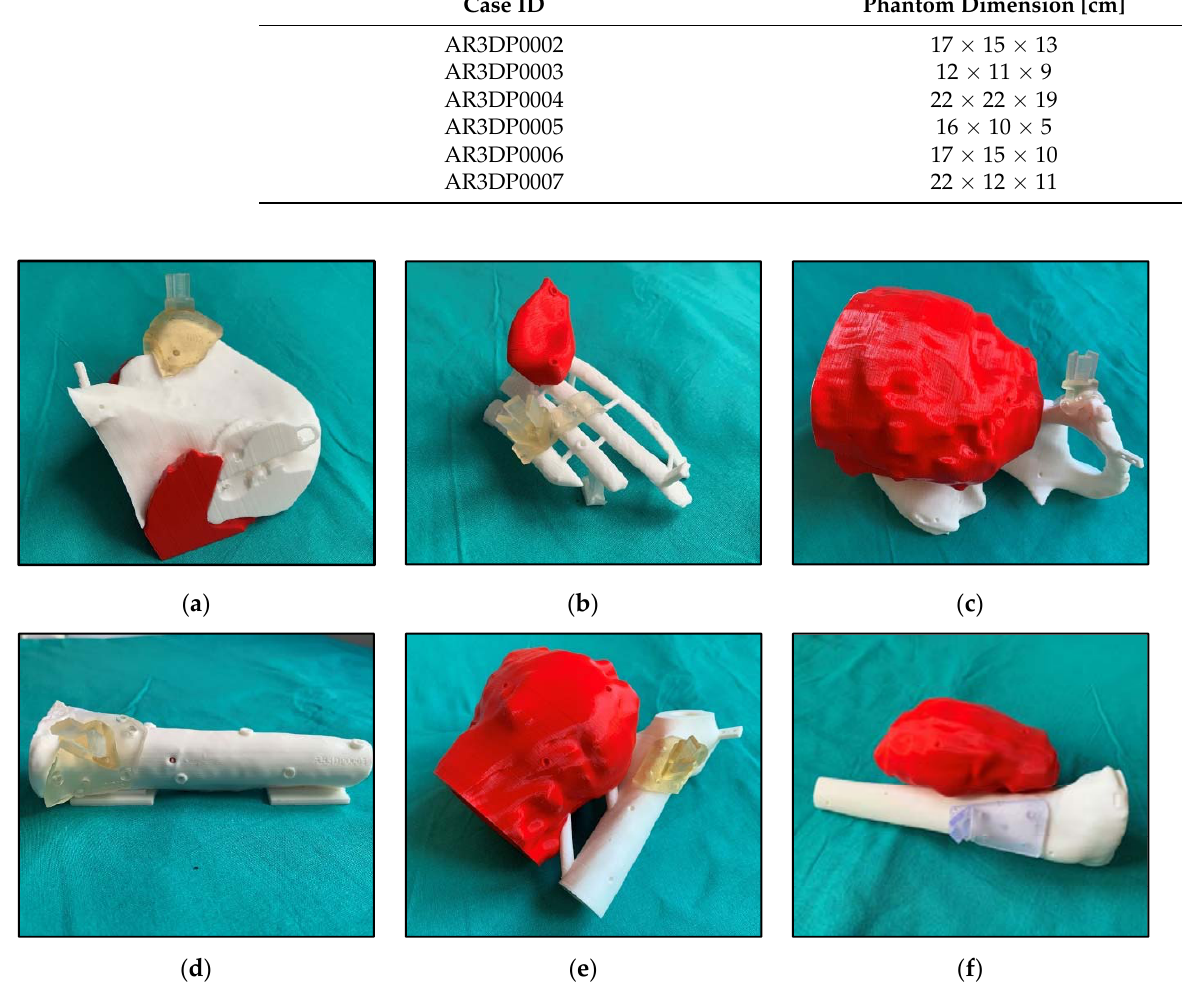
Figure 5. 3D printed patient-specific phantoms from patient: ( a ) AR3DP0002; ( b ) AR3DP0003; ( c ) AR3DP0004; ( d ) AR3DP0005; ( e ) AR3DP0006; ( f ) AR3DP0007. Bones are in white, the tumors are in red, and the resin surgical guides are fitted on their corresponding position.